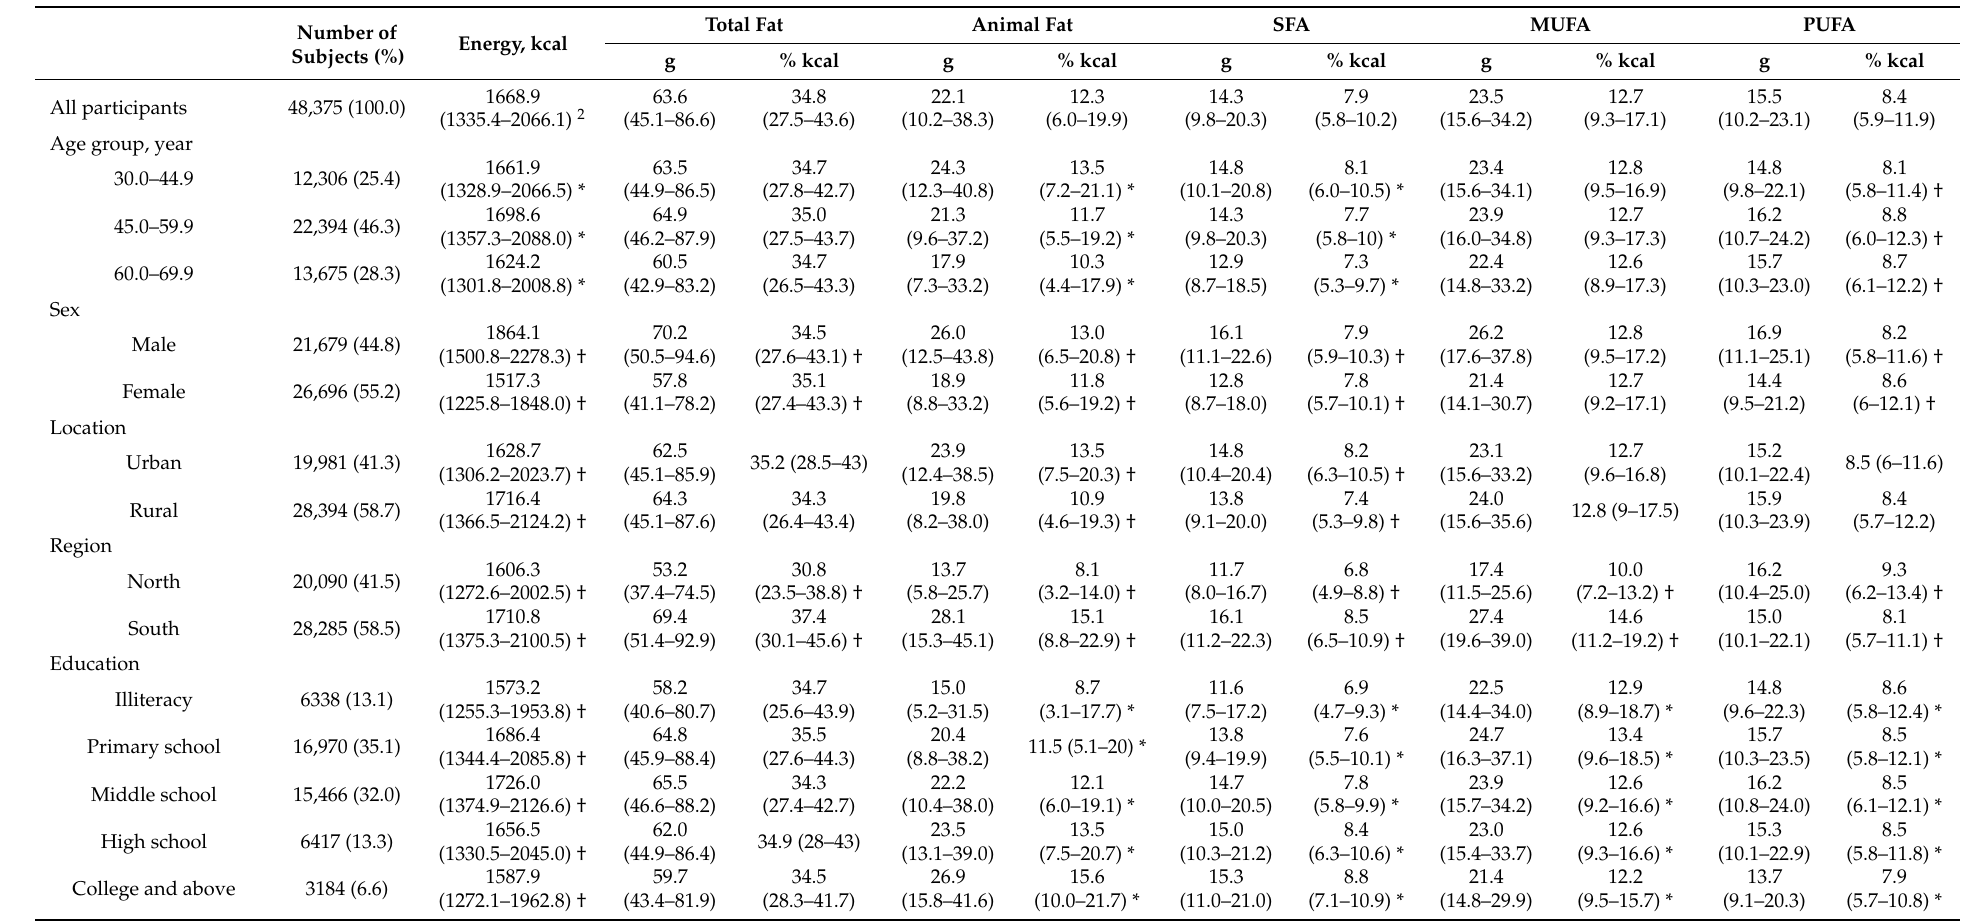
Table 1. Age-sex-standardized intakes of dietary energy, fat, and fats of various types and sources in Chinese adults with different characteristics ( n = 48,315) 1